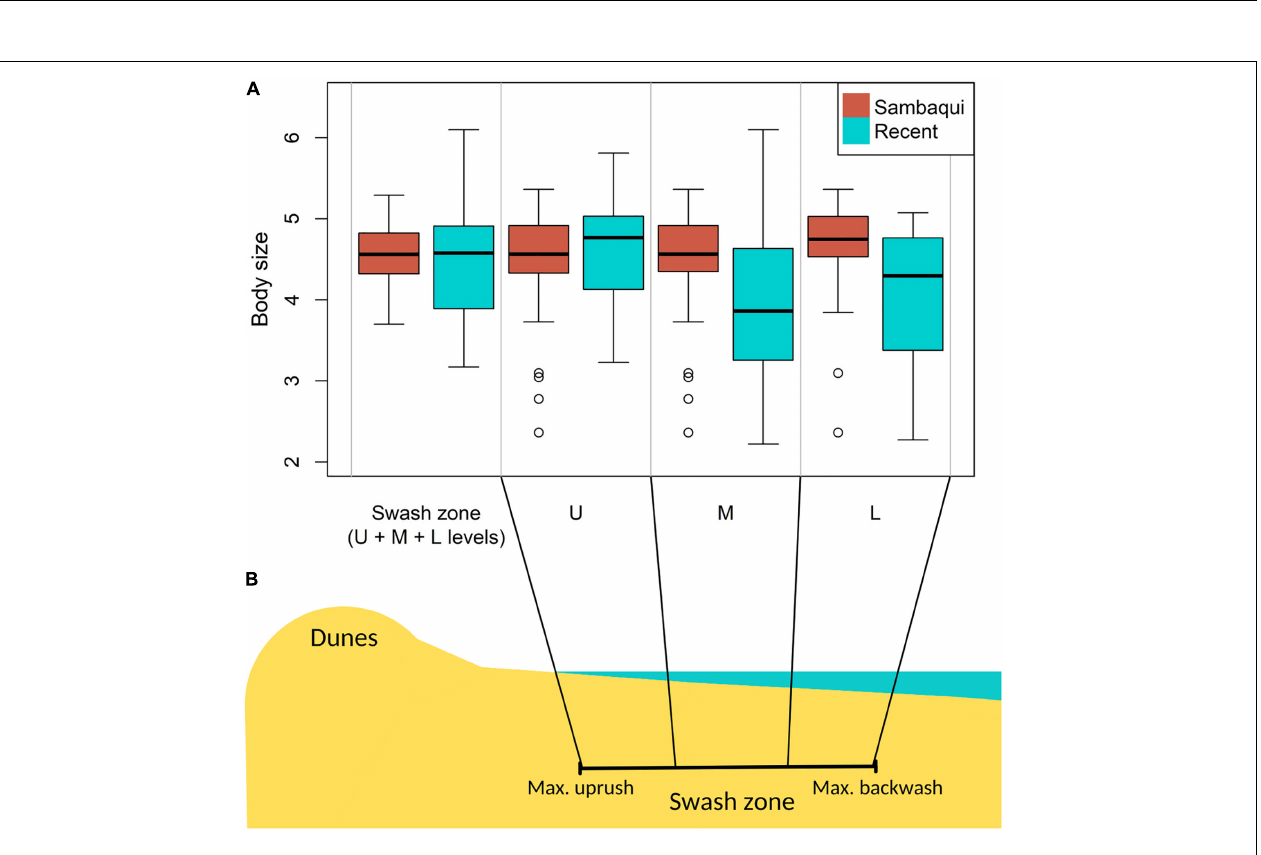
Frontiers in Ecology and Evolution |